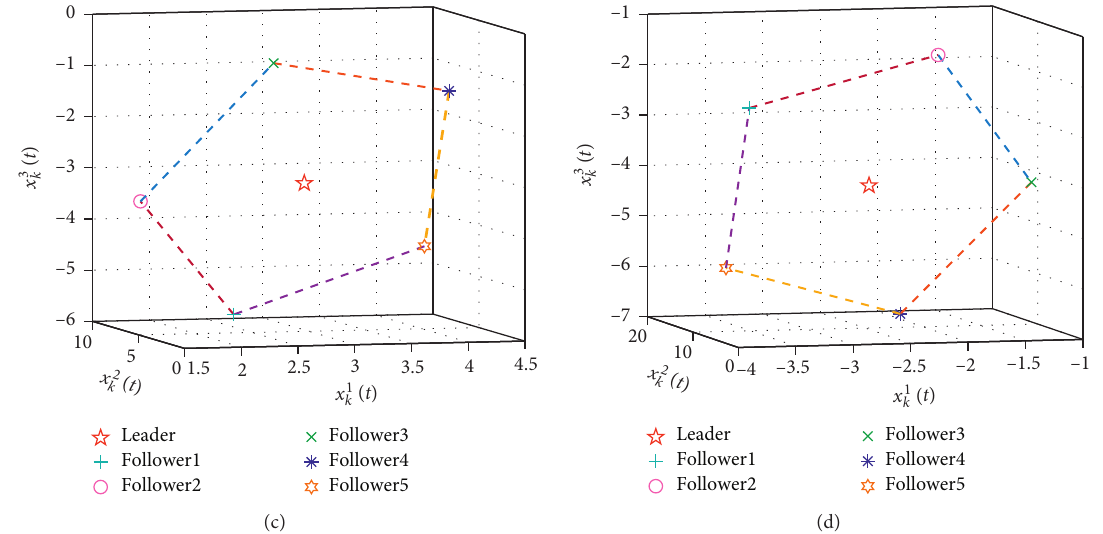
Figure 3: State snapshots of all the agents at different time for time-varying formation tracking case: (a) t � 0s, (b) t � 16s, (c) t � 18s, and (d) t �